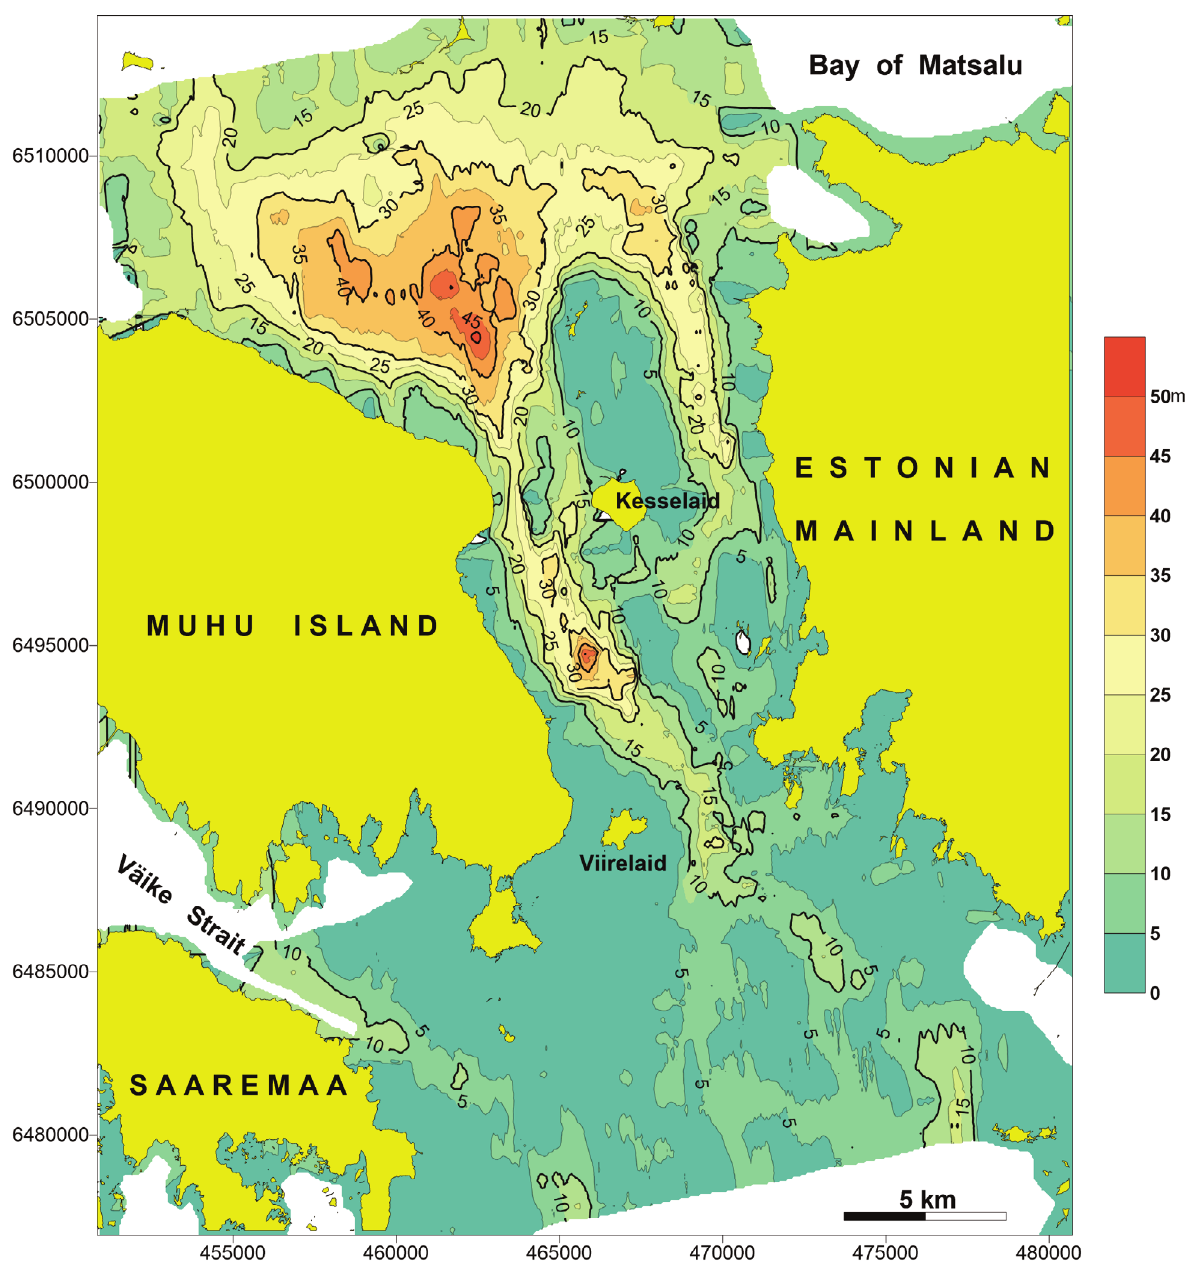
Fig. 10. Thickness map of the Quaternary